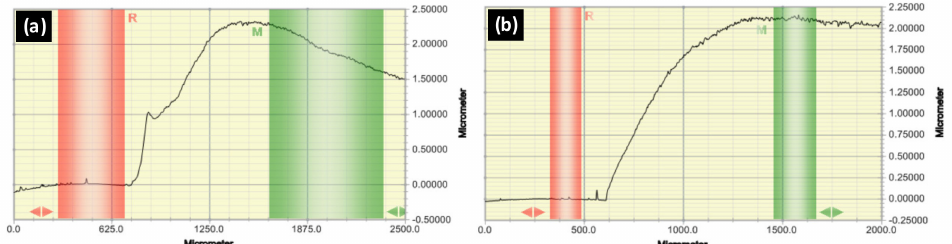
Figure 12. ( a ) Measured outcomes generated with direct printing with the conventional method, wherein the test area is the edge of the sheet resistivity sample. The lowest area on the left is the substrate, and the elevated area on the right denotes the solid nanosilver particle residue that remains after the ink is dried. The cumulative thickness of the ten-layer nanosilver ink is approximately 2 µ m. ( b ) Generated results with the use of this scheme have better surface flatness as those in Figure